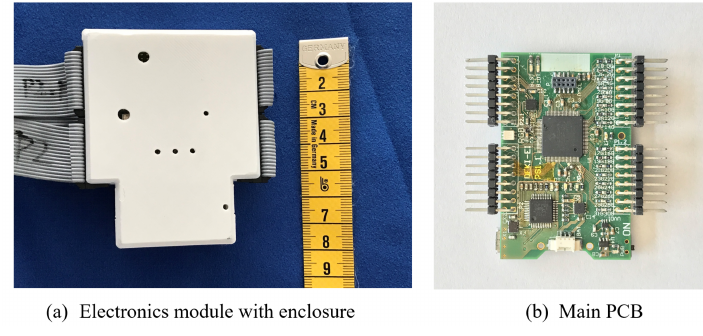
Figure 2. Electronic Hardware.